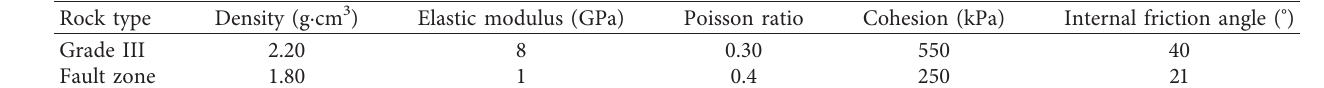
Figure 4: (a) Dynamic numerical model and its (b) boundary conditions. Table 2: Properties of rock material (updated from Yu [32]).